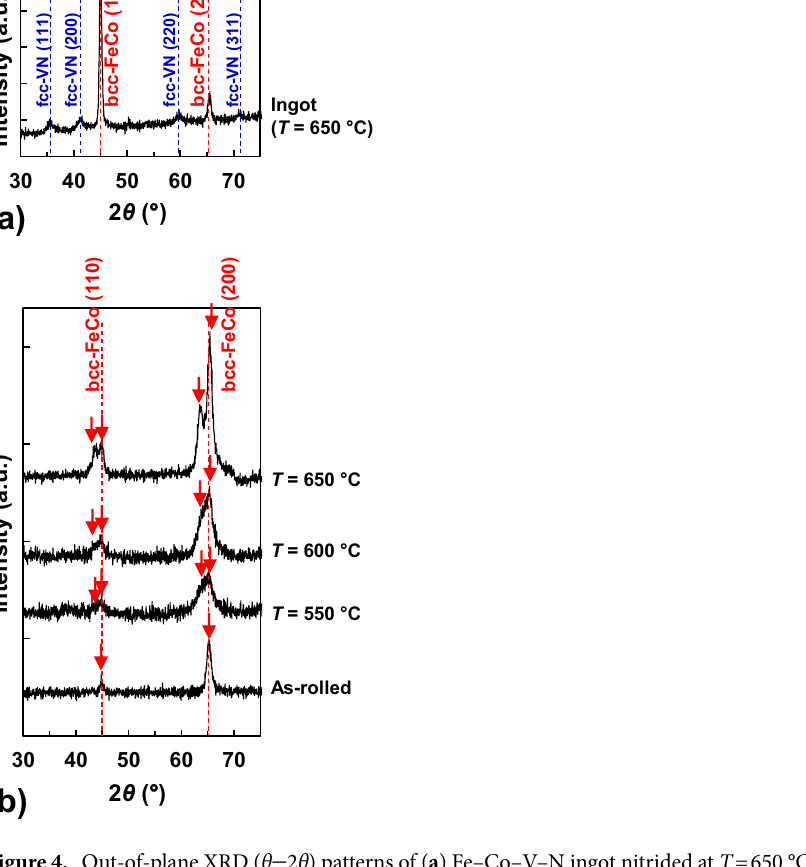
Figure 4b shows the XRD patterns of the as-rolled Fe–Co–V foil ( t = 55 µm, without nitriding) and Fe–Co–V–N foils (with rolling, t = 55 µm) nitrided at 550, 600, and 650 °C, with red arrows indicating peak positions. The patterns of all samples featured the peaks of bcc FeCo (110) and bcc FeCo (200) at approxi- mately 45° and 65°, respectively. The FeCo (200) peak was more intense than the (110) peak, which suggested a progression of the (200)- and/or (002)-orientation during rolling. Such rolling-induced improvements in the {200}-orientation of FeCo have been reported previously 16 . Other peaks (e.g., fcc V–N) were also observed but were rather weak. Although V-rich phases (red lumps) were observed in the bottom area of Fig. 3, their low volume fractions precluded the detection of the corresponding peaks (typical bcc V (110) and (200) peaks appear at 42.2° and 61.2°, respectively 17 ). These results suggest the formation of a polycrystalline FeCo-based alloy with a c -axis ([002]-direction) directed parallel and/or perpendicular to the sample plane. The peaks observed at approximately 45° and 65° both changed to twin peaks with increasing T . The peak at approximately 45° was split into signals at ~ 43.5° and ~ 45°, and the peak at approximately 65° was split into signals at ~ 63° and ~ 65.5°. Herein, two cases were assumed for the appearance of these twin peaks, with the first one corresponding to the formation of a single-phase Fe–Co–V–N bct structure. Focusing on the twin peak at approximately 65°, the left peak (decreasing angle side) corresponds to the bct FeCo (002) peak, and the right peak (increasing angle side) corresponds to the bct FeCo (200) peak. In this case, the c / a value of the sample at T = 650 °C was estimated as 1.03. The second case assumes the combination of two phases, namely the bcc FeCo phase and the fcc V–N phase. Both cases are discussed in detail in the next section.